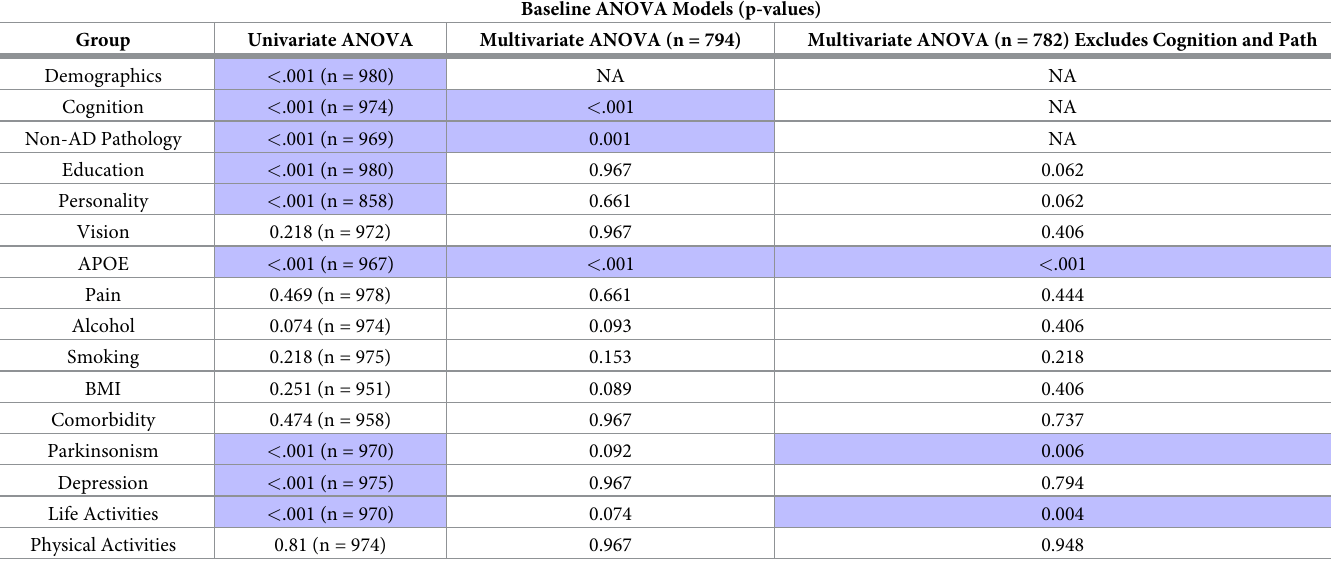
Table 3. Table of the FDR adjusted p-values from the baseline ANOVA models.